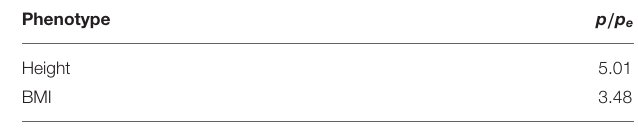
the empirical covariance matrices. Our approximation of the